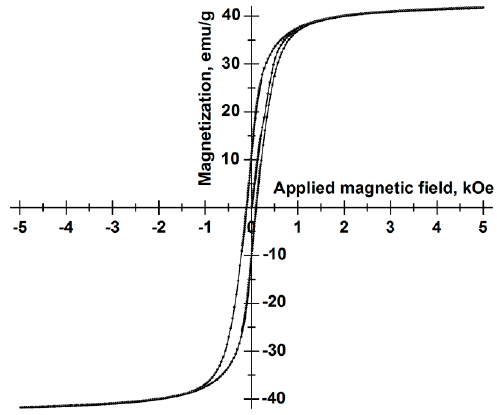
Figure 3. Magnetic hysteresis loop for Co x B-Cl catalyst measured at 20 ° С .